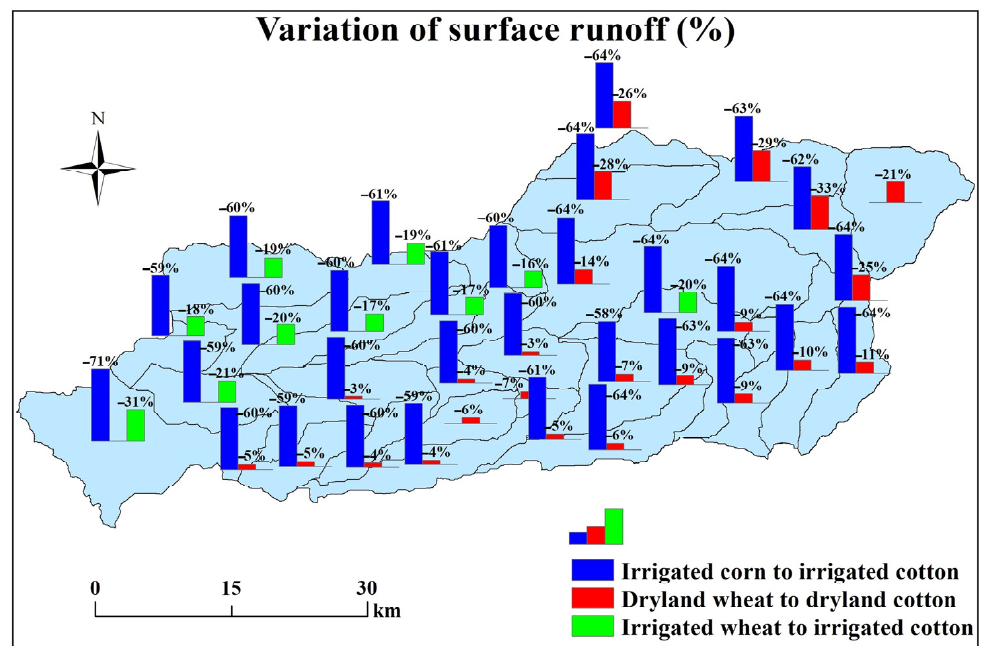
Figure 2. The spatial distribution of simulated annual irrigation and ET a under cotton land-use change scenarios in the Palo Duro watershed.